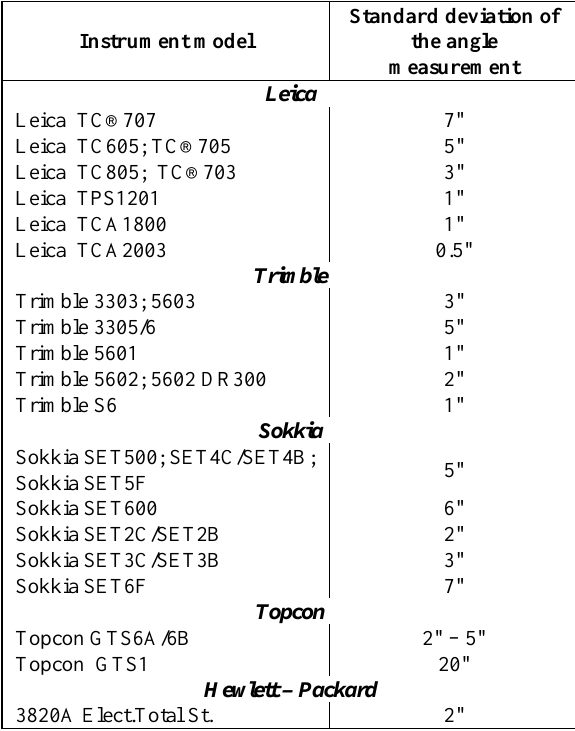
Table 2. Technical specifications of the most commonly used electronic tacheometers Instrument